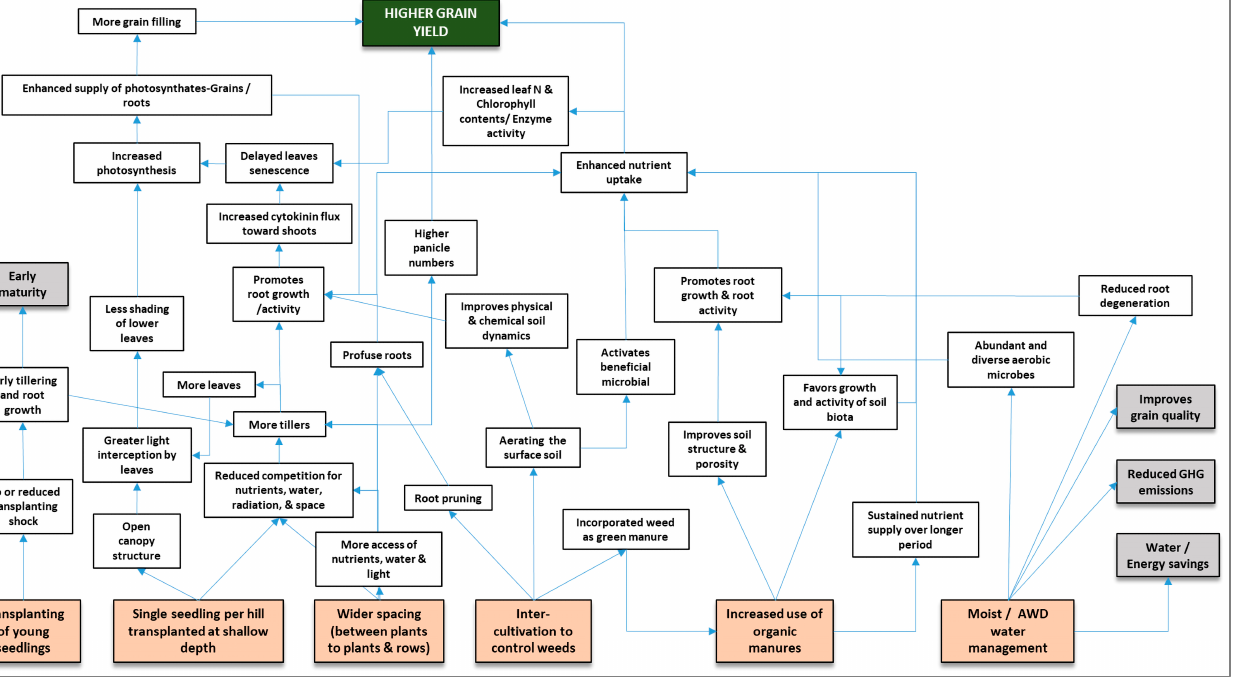
Figure 6. A flow diagram showing the effects of SRI management practices responsible for increased grain